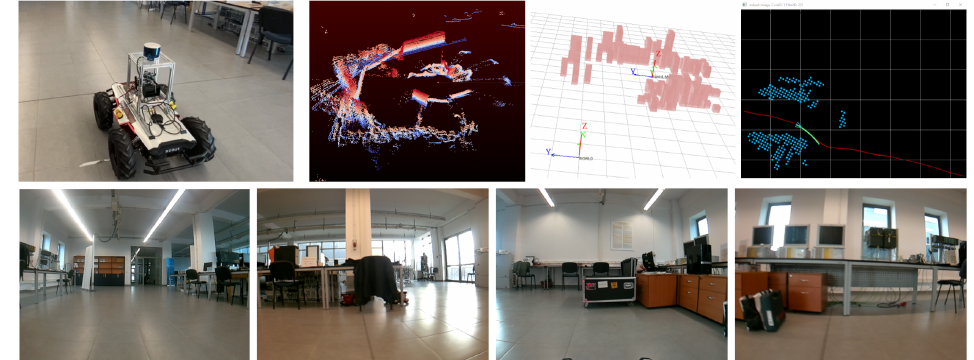
Figure 5. Indoor testing setup. (top) RovisLab AMTU on the reference trajectory, with raw LiDAR data acquired from the top-mounted sensor and the generated 3D and projected 2D octree environ- ment model. (bottom) The 4 images were acquired with the e-CAM130A quad camera. The order of the images is, given the camera mounting position, front-right-back-left.